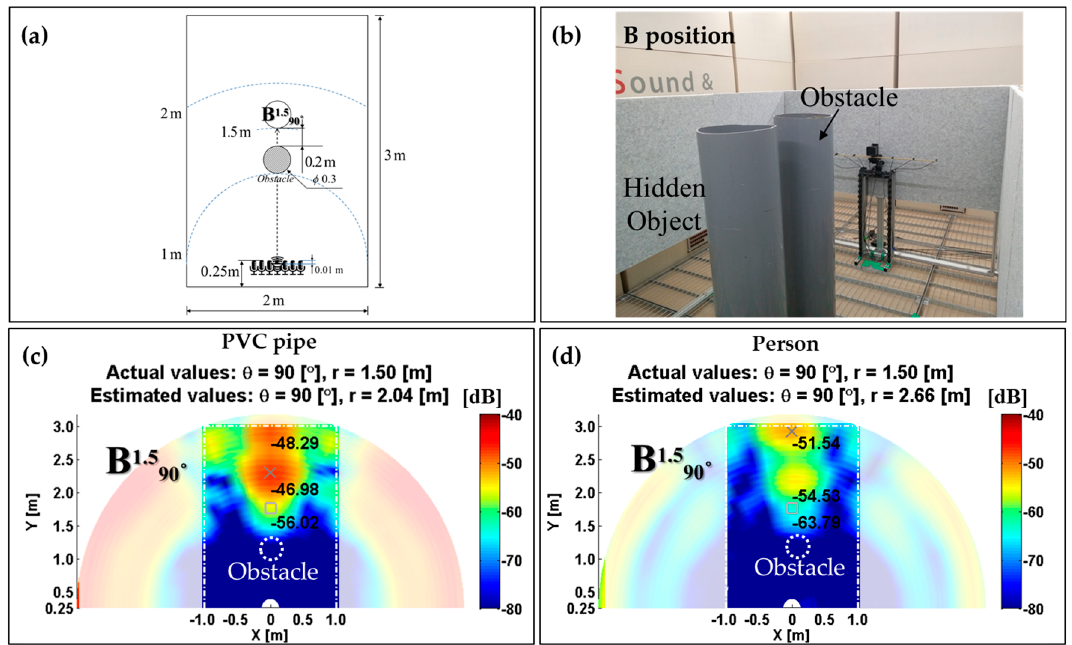
Figure A2. Experimental setup and results of a hidden object and a hidden person: ( a ) Experimental configuration of the detection performance; ( b ) An experimental picture; Energy maps of ( c ) a hidden PVC pipe and ( d ) a hidden